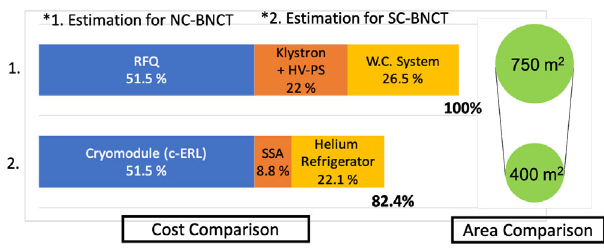
FIG. 15. Relative ratio of the estimation of NC-BNCT to that of SC-BNCT. Histogram and circle graph represent the cost and the area estimated by J-PARC and c-ERL at KEK, respectively.